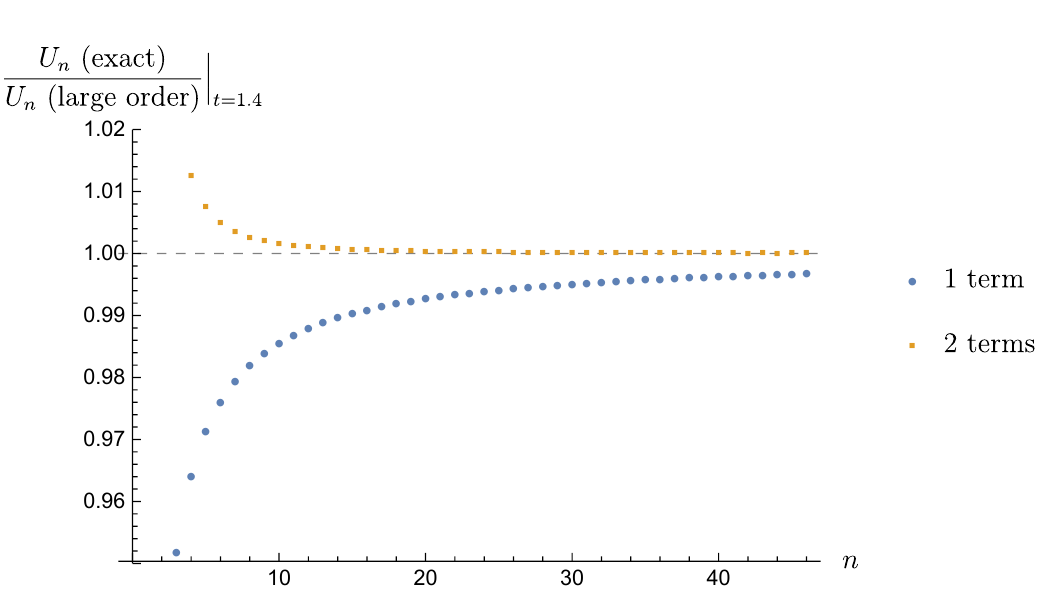
Figure 9 . Ratio of the exact perturbative coe(cid:14)cients U n ( q ( t )) from the Debye expansion (5.33), divided by the resurgent large-order growth expression (5.37). Both plots are for t = 1 : 4, and include just the (cid:12)rst term in (5.37) [blue circles] or the (cid:12)rst two terms [gold